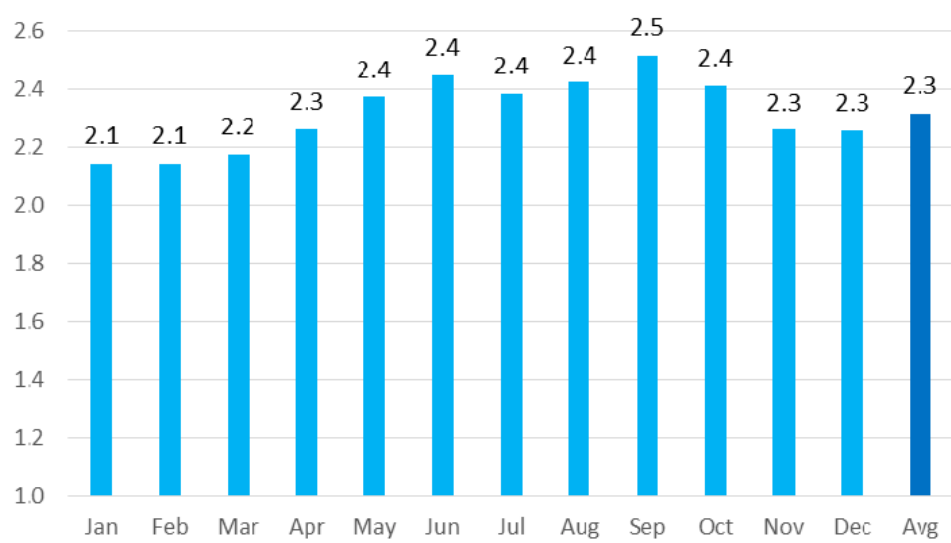
Figure 4. WET calculation for Villahermosa climate.